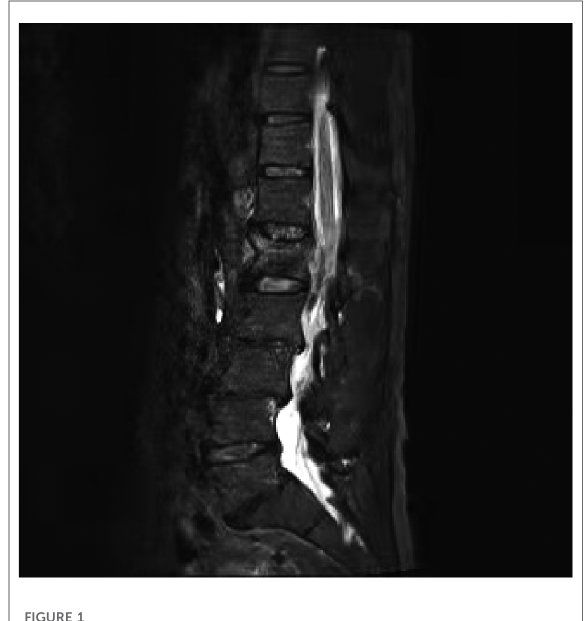
FIGURE 1 MRI showing fresh compression fracture of L1 vertebrae.